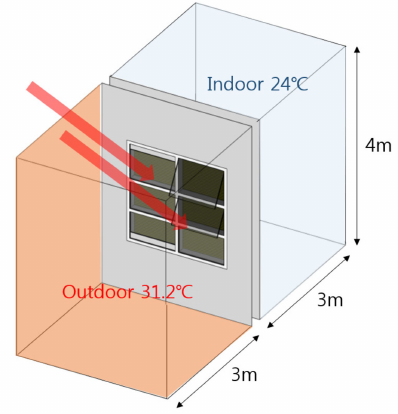
Figure 2. Space layout of fluid